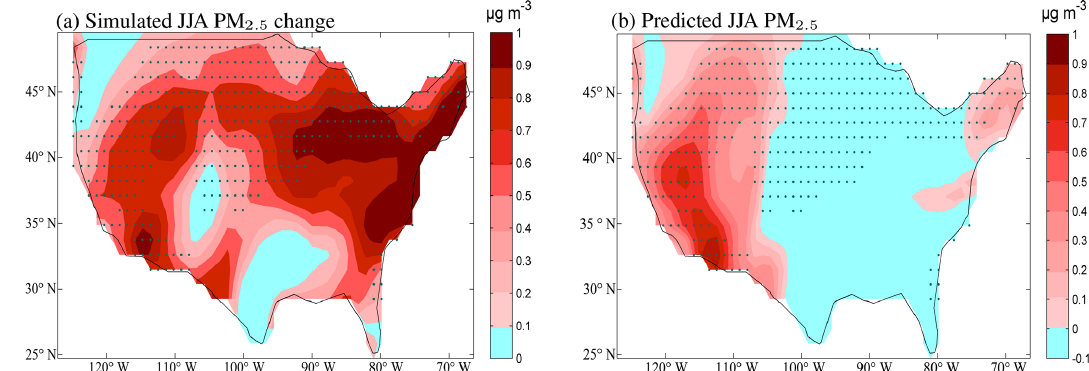
Figure 9. (a) Simulated change in JJA PM 2 . 5 between simulated future climate (future climate with current emission, GCM2100, 2106– 2125 mean) and current climate (current climate from the coupled model simulation, GCM2000, 2006–2025 mean). (b) Predicted JJA PM 2 . 5 change using the linear regression model fitted with simulated current PM 2 . 5 (GCM2000, 2006–2025 mean). Stippling indicates where R 2 is significant (at the 5% significance level) at model grids. Unit: µgm − 3 for PM 2 . 5 .